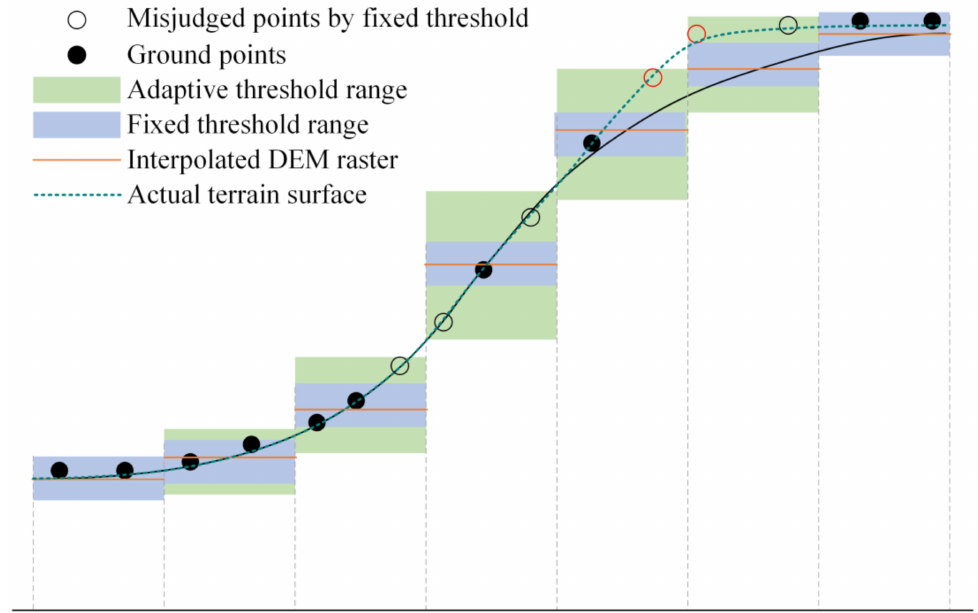
Figure 3. Distinguishing ground points by the adaptive threshold based on relief